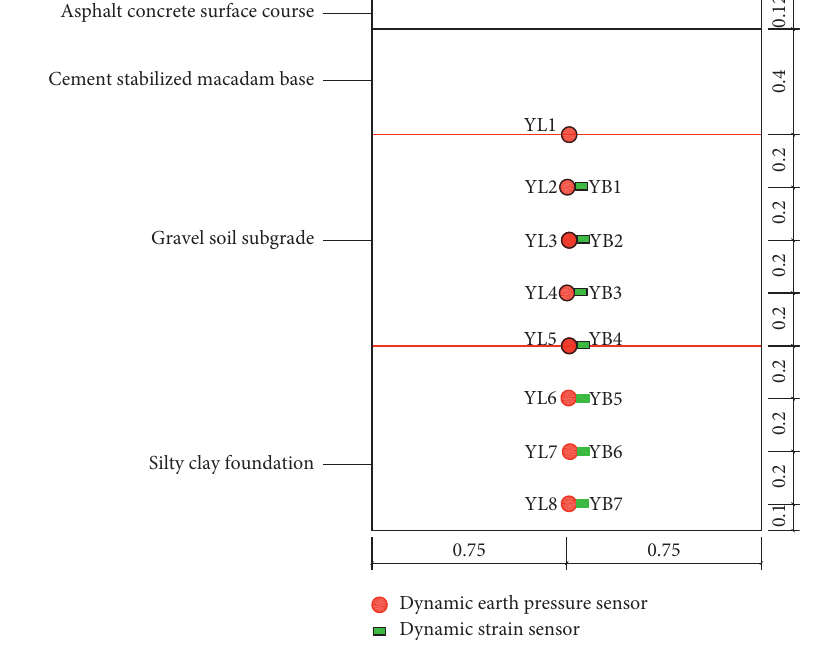
Figure 1: Model structure hierarchy and sensors layout (units in (m)). Table 1: Basic physical and mechanical parameters of gravel soil and silty clay. Coefficient of Coefficient of Maximum Specimen nonuniformity curvature